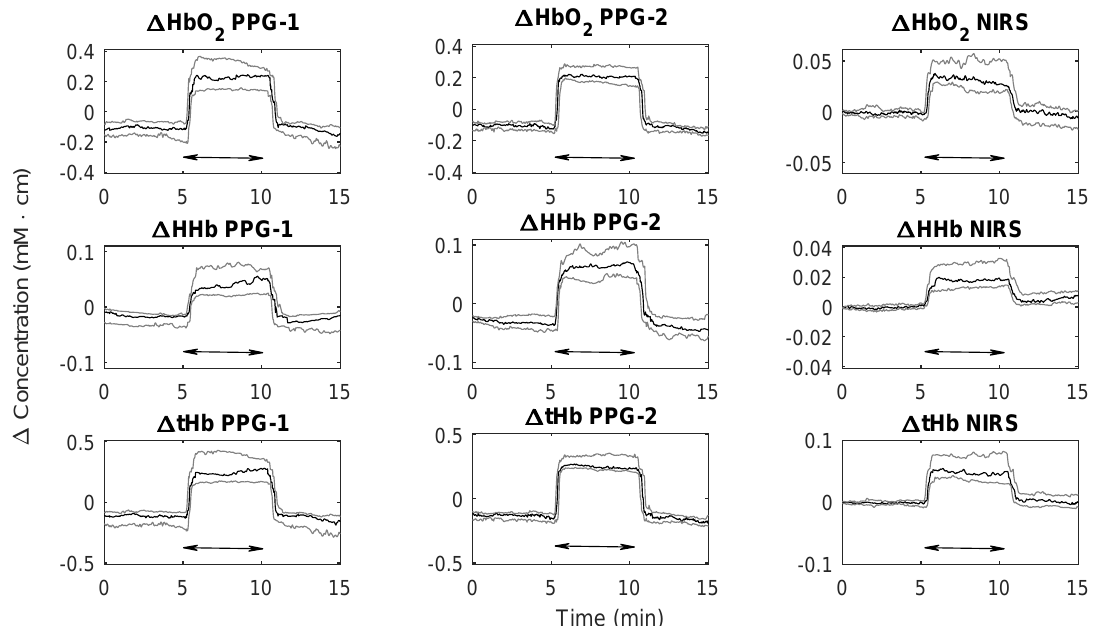
Figure 3. Changes in ∆ HbO 2 , ∆ HHb, and ∆ tHb estimated from the PPG sensors and the reference NIRS monitor during the bed tilting protocol. Black lines indicate the medians across all subjects, while the grey lines show the upper and lower quartiles among the subjects. The double arrows indicate the duration of the head-down